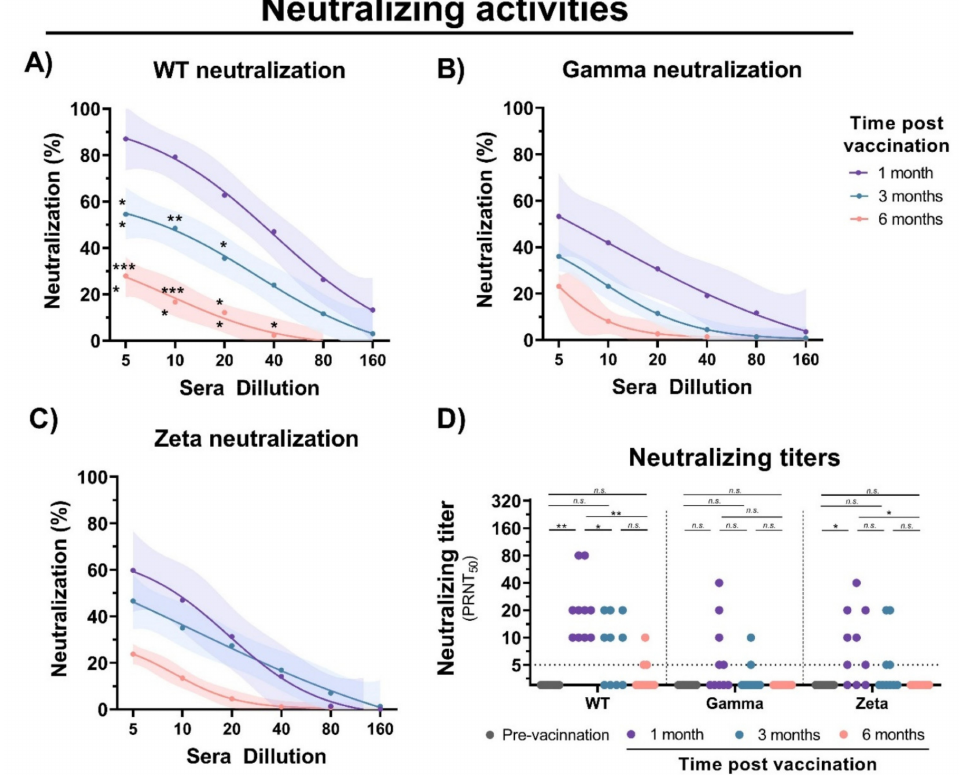
Figure 2. Neutralizing activity of sera from CoronaVac-vaccinated individuals. Serial dilutions of serum samples were prepared, and neutralization activity was evaluated against ( A ) WT SARS- CoV-2, and ( B ) Gamma and ( C ) Zeta variants at 1, 3, and 6 months after second dose. Nonlinear regression curves generated with a maximum of 1000 interactions and 95% confidence interval. Error bars delimited by colors. Multiple comparisons were performed by two-way ANOVA followed by Sidak’s post hoc test. Asterisks, significance difference compared to 1-month group. * p < 0.05; ** p < 0.001; *** p < 0.0001. ( D ) PRNT50 neutralizing titers of WT SARS-CoV-2, and Gamma and Zeta variants using sera from vaccinated individuals collected at different time points, indicated by black (prevaccination), purple (1 month), turquoise (3 months), and red (6 months). Multiple comparisons were performed by one-way ANOVA followed by Tukey’s post hoc test. * p < 0.05; ** p < 0.001. PRNT50 = 50% plaque reduction neutralization test; n.s.= not statistically significantly; LOD = limit of